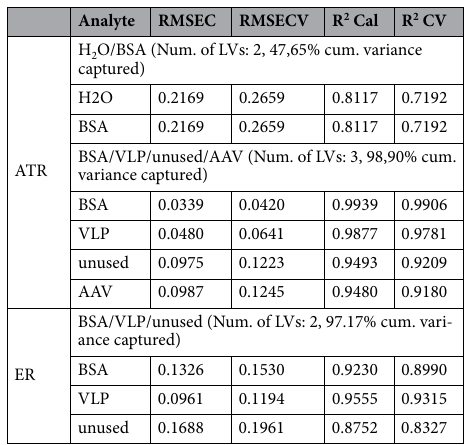
Table 1. Calibration and classification statistics of the calculated PLS-DA models based on IR-ATR spectra.